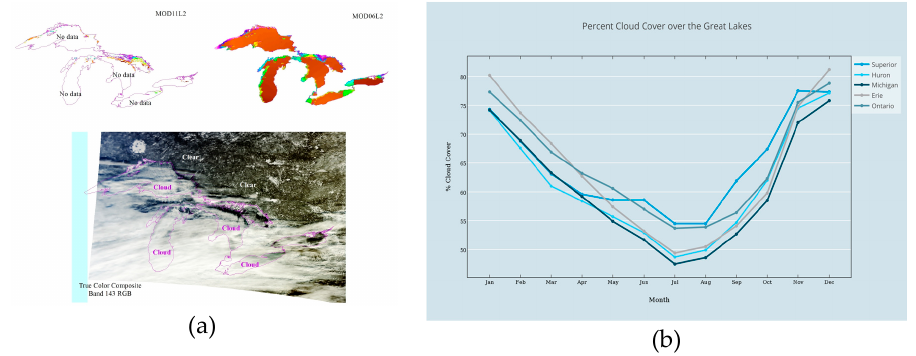
Figure 2. Comparison of percent data coverage between MOD11L2 and MOD06L2 over the